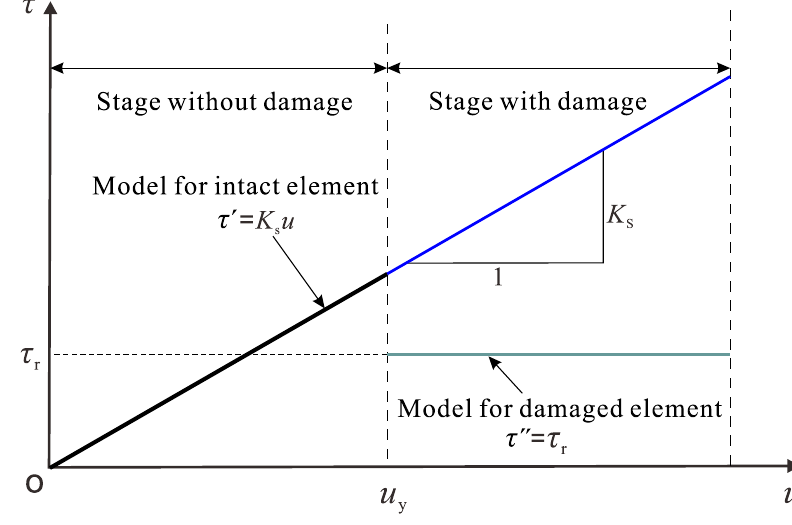
Figure 4. Mechanical response model of soil microelement .